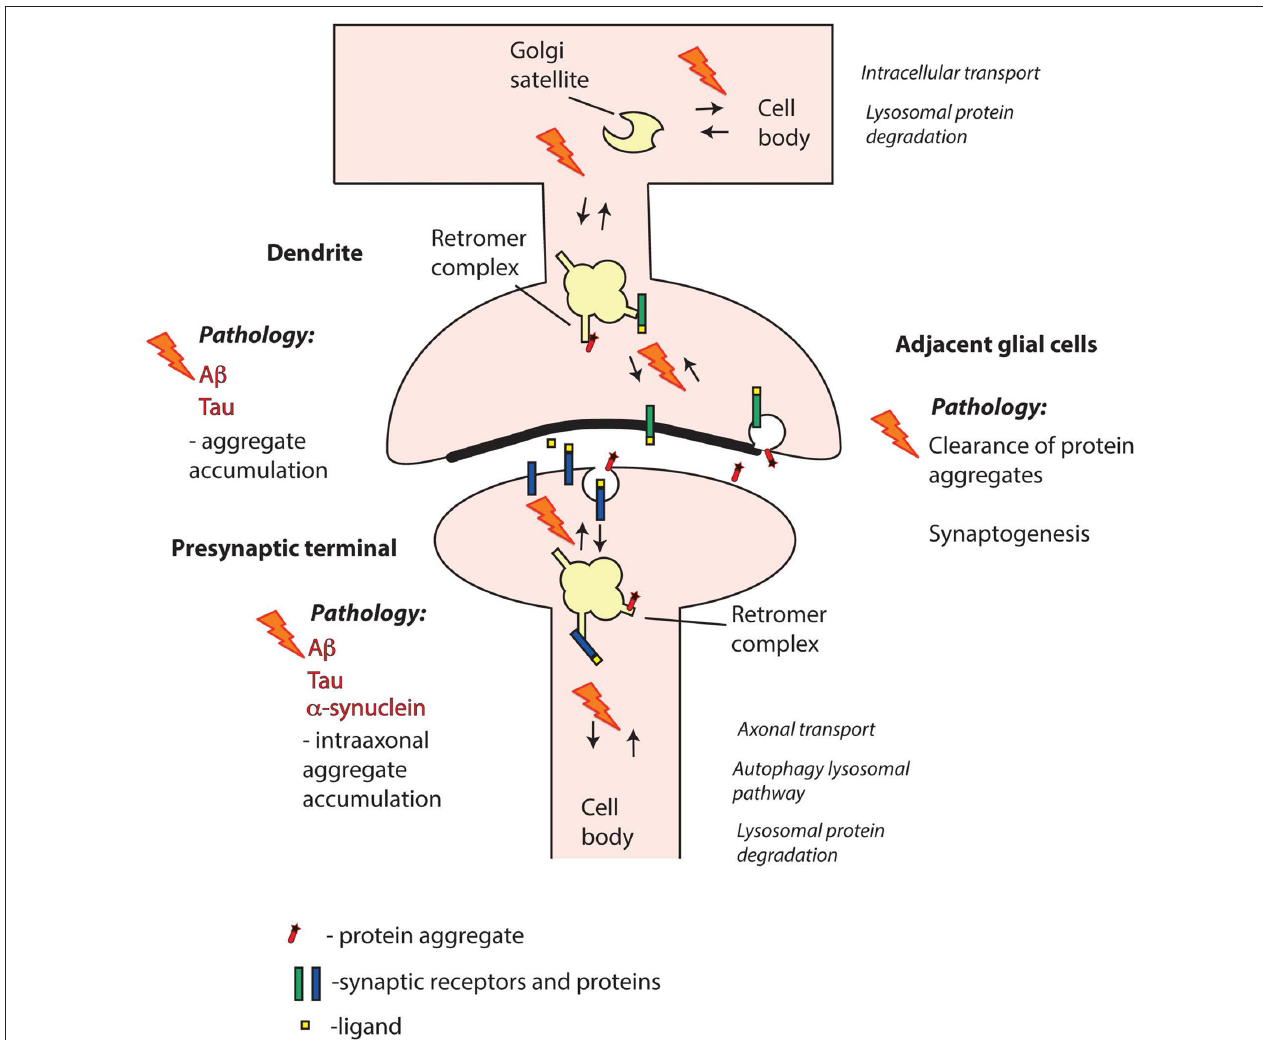
FIGURE 3 | Retromer failure at different synaptic sites may contribute to neurodegenerative disorders. A β and Tau are key pathogenic proteins in Alzheimer’s disease (AD) that can impair both pre- and postsynaptic functions. α -synuclein is a presynaptic protein strongly linked with Parkinson’s disease (PD). Mutations or altered expression/processing of retromer components may result in impaired retromer function in pre- and/or postsynaptic compartments and perturbed protein degradation. Moreover, retromer dysfunction in adjacent glial cells, including both microglia and astrocytes, may contribute to decreased clearance of pathogenic proteins from the synaptic region. Retromer defects may also trigger aberrant phase separation of key proteins that can contribute to aggregate formation. Overall, impairment of retromer function at synapses may thus result in various defects in the handling of A β , Tau and α -synuclein leading to pathological aggregate formation.